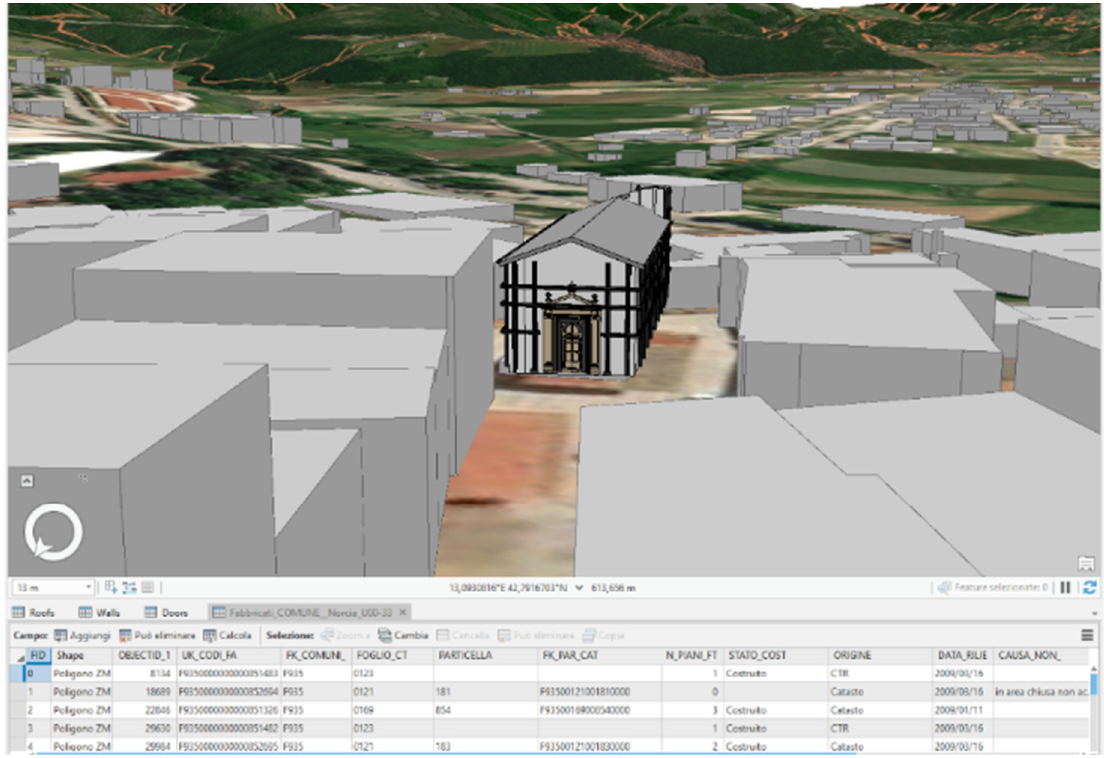
Figure 10. Three-dimensional visualization of LoD 3 in ArcGIS Pro.